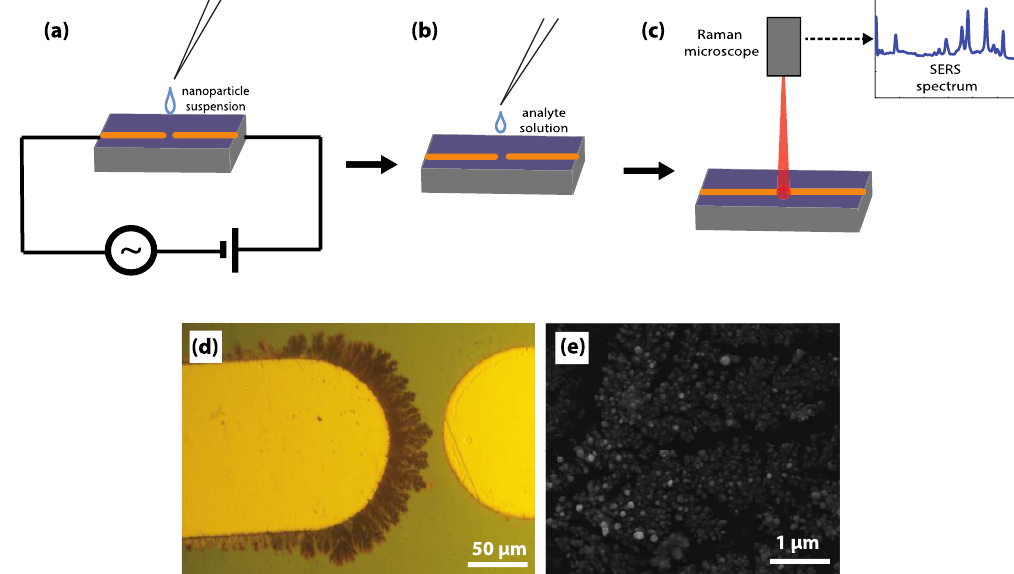
Figure 1. Preparation of the surface-enhanced Raman scattering (SERS) substrate used for detection of food contaminants in liquid food. ( a ) With the nanoparticle solution sitting at the tips of the microelectrodes, the gold microelectrodes are connected to the mixed AC/DC voltage supply to form the SERS-active nanostructures. ( b ) The nanoparticle suspension is removed, and the analyte solution is dropcast upon the surface of the microelectrodes. ( c ) The Raman microscope is used to analyze the gap region between the two microelectrodes, where both the SERS active structures and the analyte have been deposited. ( d ) Between the microelectrode tips, dendritic silver nanostructures grow from the positively biased tip. ( e ) A scanning electron microscopy (SEM) image of the dendritic silver nanostructures.